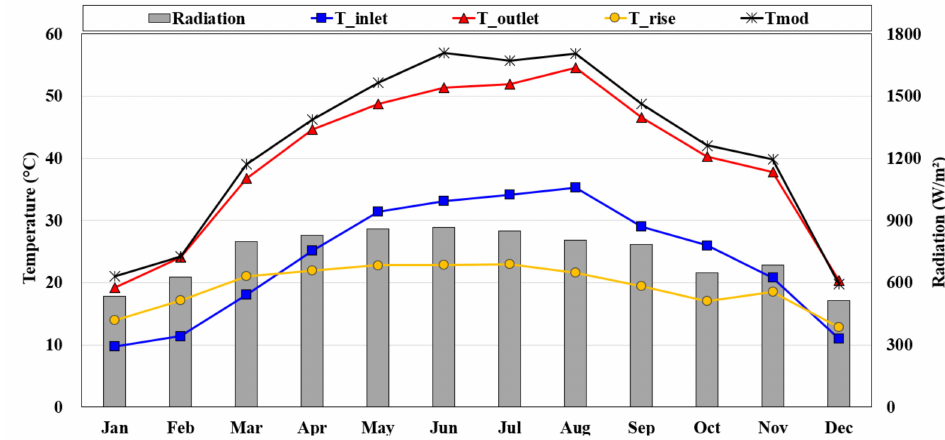
Figure 10. Monthly temperature fluctuations for PVT collector.